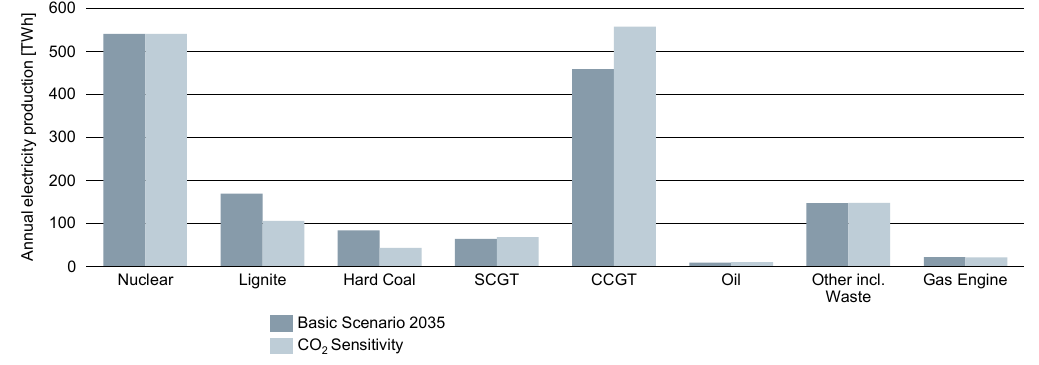
Figure 19. Comparison of annual generation in Europe for base scenario and increased CO 2 prices (see Section 2.1.2. Further